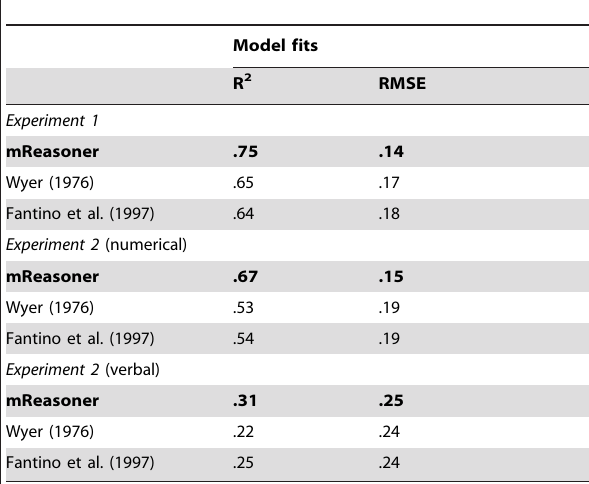
Experiments 1 and